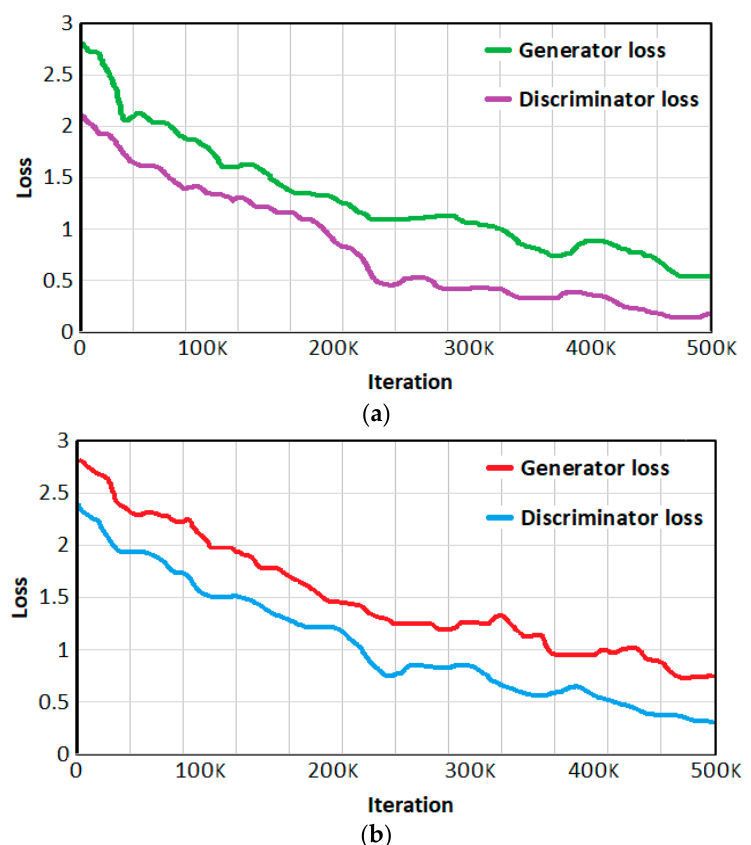
Figure 6. Loss curves of IPGAN-2 with ( a ) training data and ( b ) validation data. Table 11. Search space and selected values of hyperparameters.